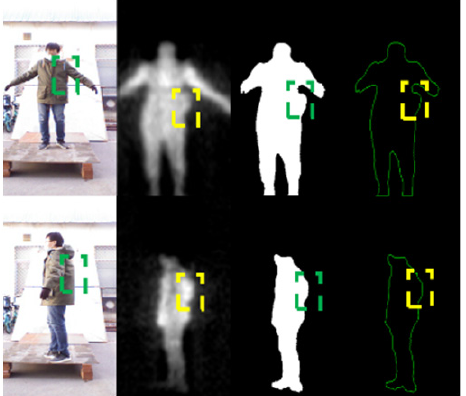
Figure 7. Illustration of PMMWI when a non-metallic threat is carried and the dashed boxes indicate the location of the threat.